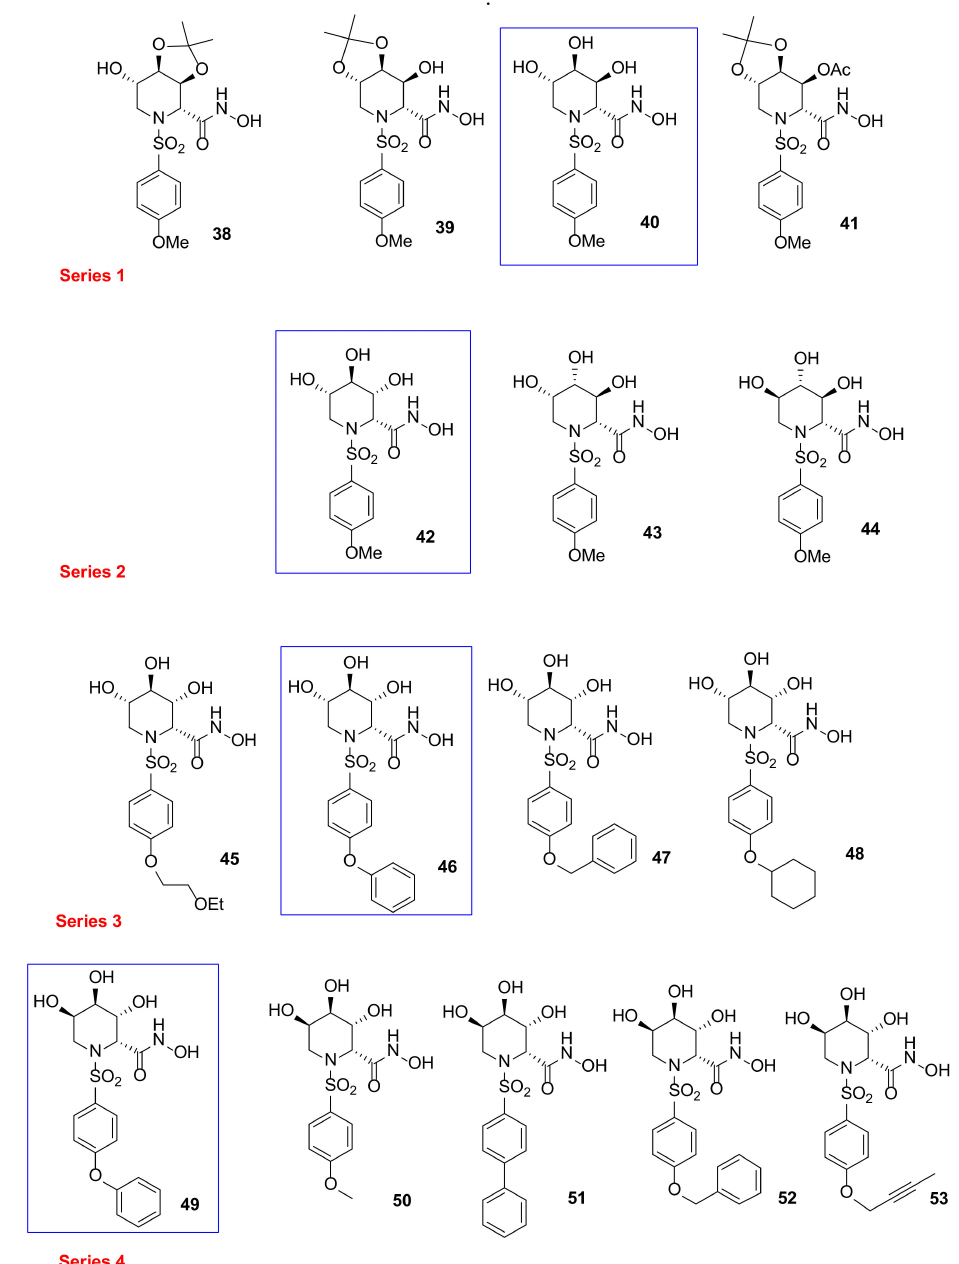
Figure 11. Chemical structure of azasugar-based MMP / ADAM inhibitors (Series